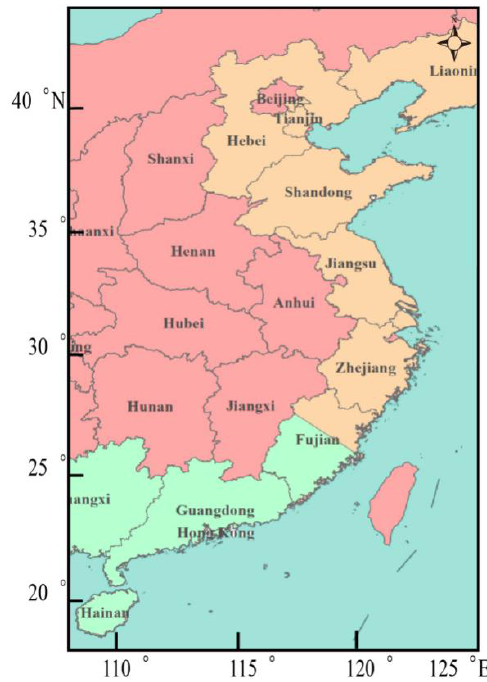
Figure 1. Coastal provinces of China where Ruditapes philippinarum (orange and green) and R. variegatus (only green) are found in natural seawater areas.